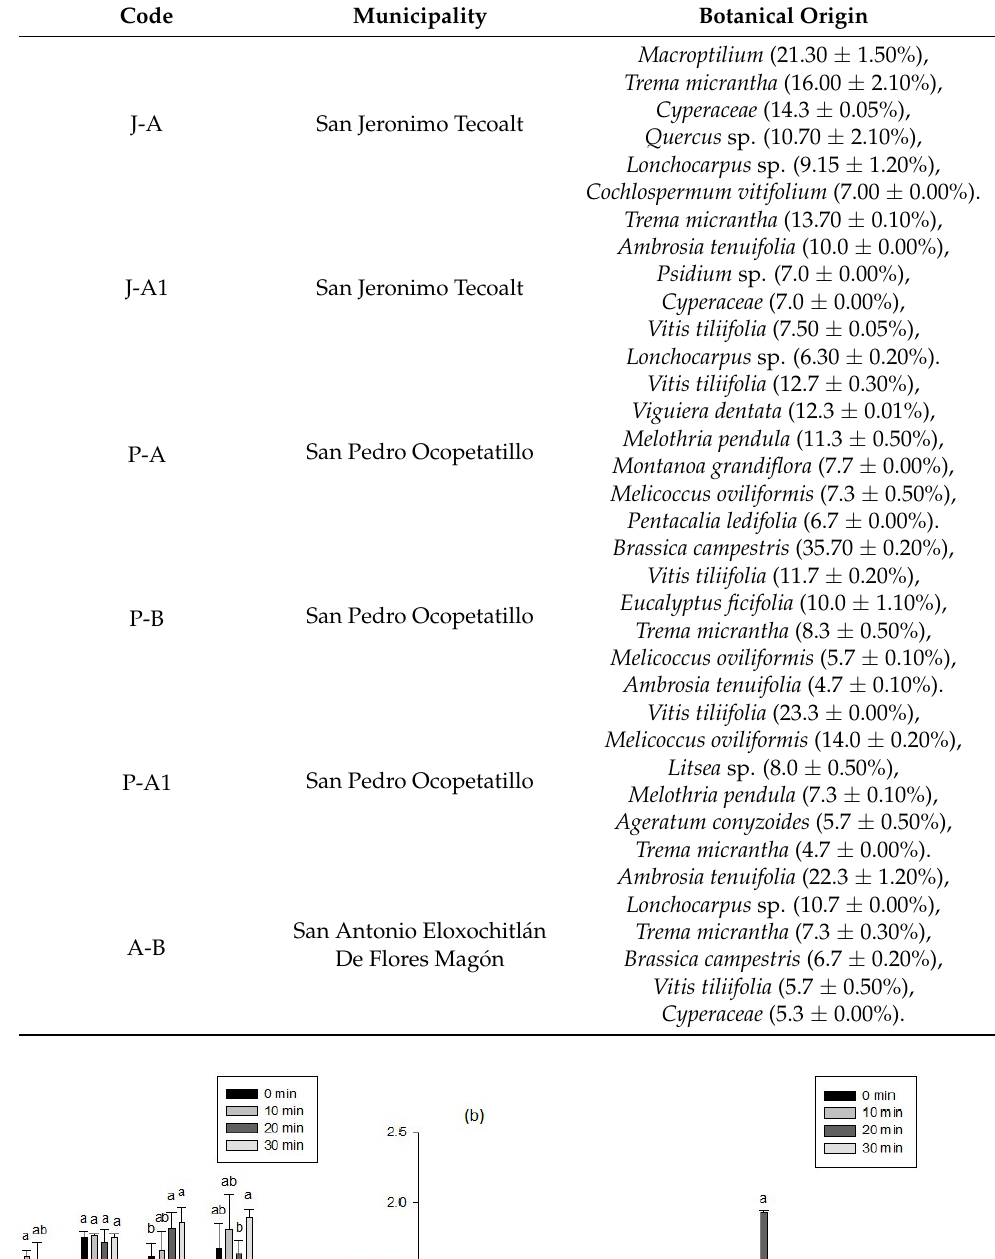
Table 1. Melissopalynological analysis of the honeys.